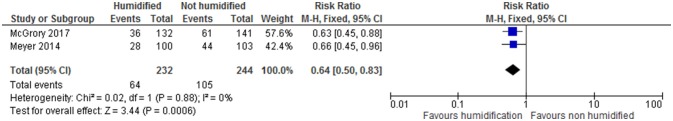
Admission temperature below 36.5°C.